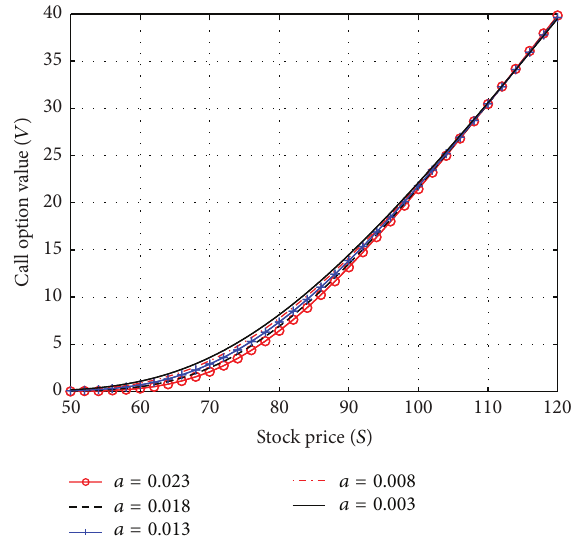
Figure 1: Asian call option pricing corresponding to the different 𝐻 .